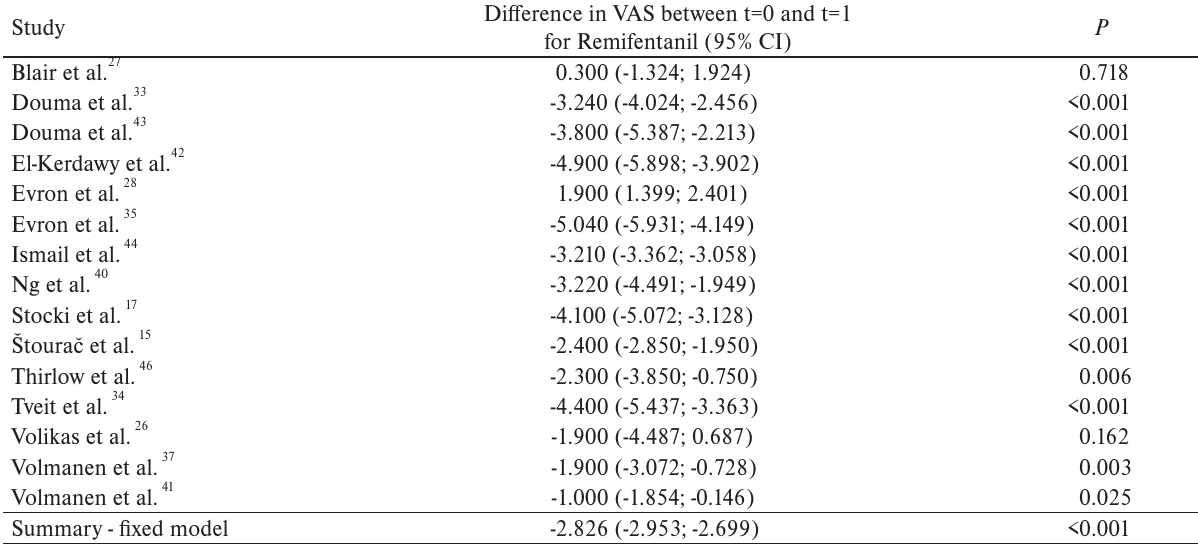
Table 6. Meta-analysis of study results comparing VAS between t=0 and t=1 hour for remifentanil.